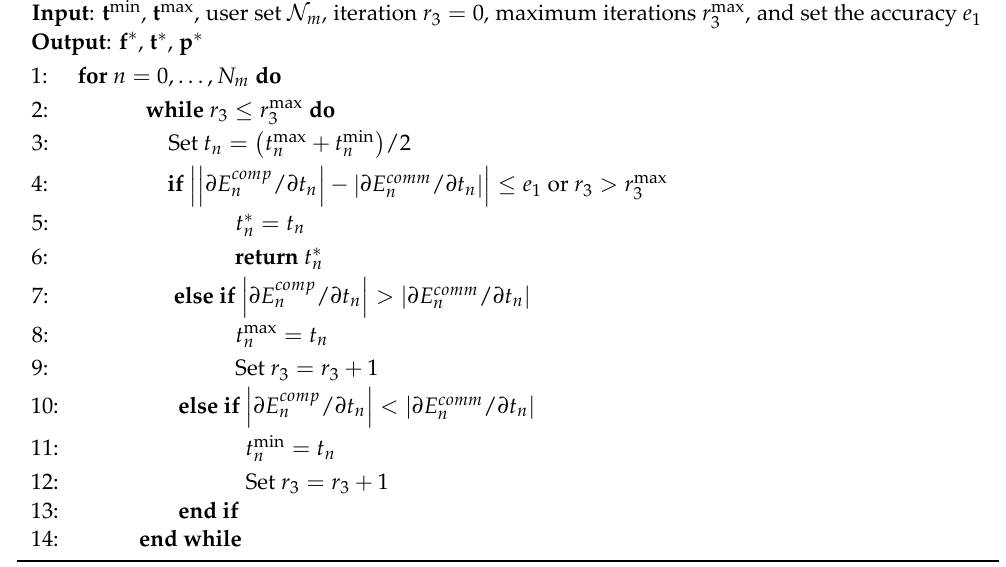
Algorithm 3 : Solve The Subproblem 3‑1: f , t ,